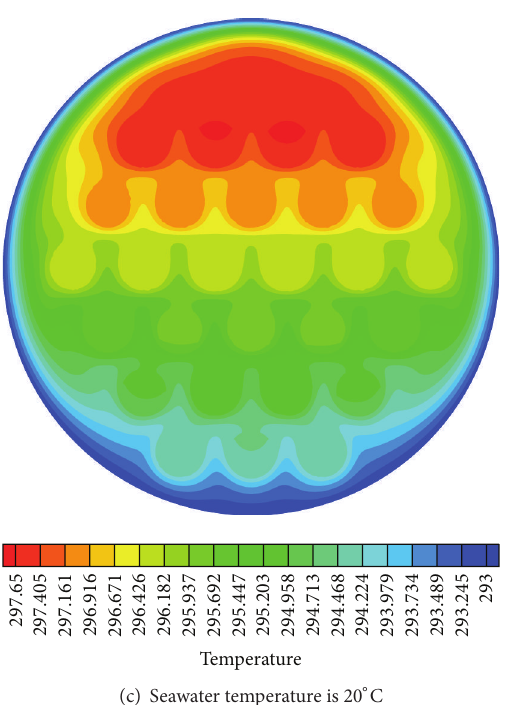
Figure 12: The battery compartment temperature distribution when the speed is